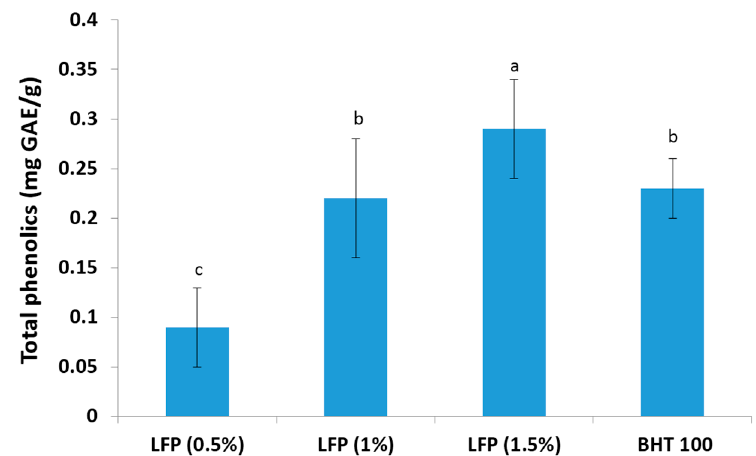
Figure 1. Total phenolics content in litchi fruit pericarp extracts (0.5%, 1.0% and 1.5%) and BHT (100 ppm). Mean values bearing different superscripts (a, b and c) differ significantly ( p < 0.05).